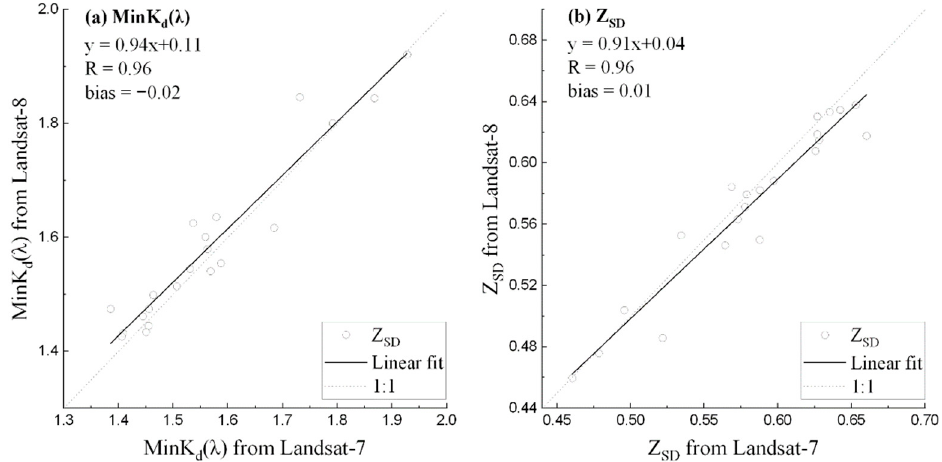
Figure 12. Average Z SD ( a ) and minK d ( λ ) ( b ) plots of 21 sample points. The value of each dot is the average of retrievals from Landsat-7 and Landsat-8 in Table 4.